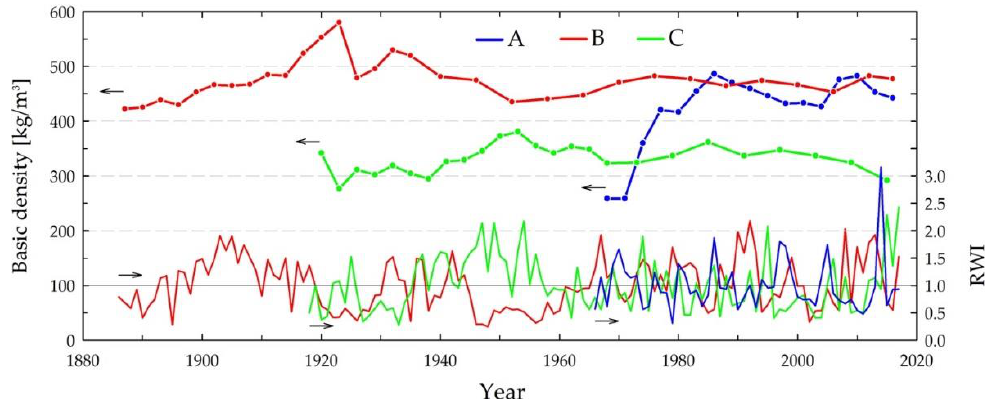
Figure 4. The radial pattern of basic density and standardised tree-ring width (RWI) of lime ( Tilia cordata Mill.) wood taking into account growth conditions (A—forest, B—roadside, C—urban agglomeration, dots represent experimental data).